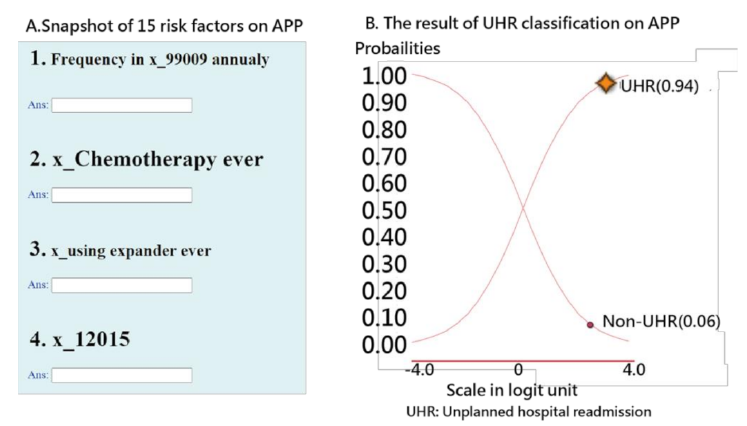
Figure 6. Snapshot of the UPRA app on a